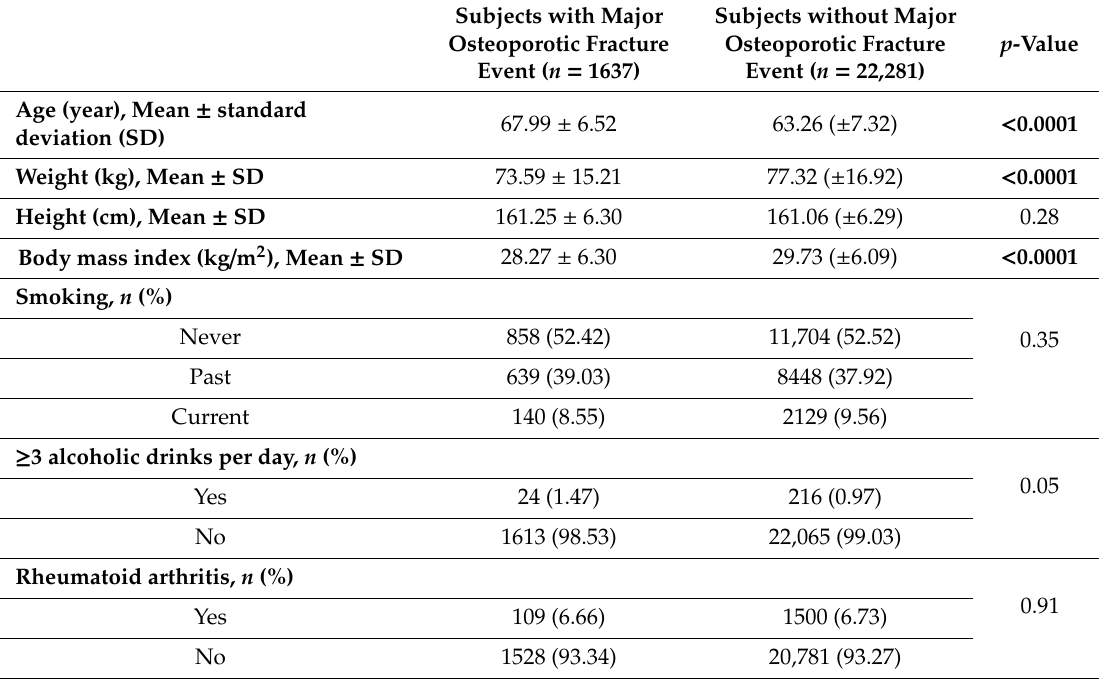
Table 1. Baseline characteristics of 23,981 women according to whether they sustained a major osteoporotic fracture (MOF) during